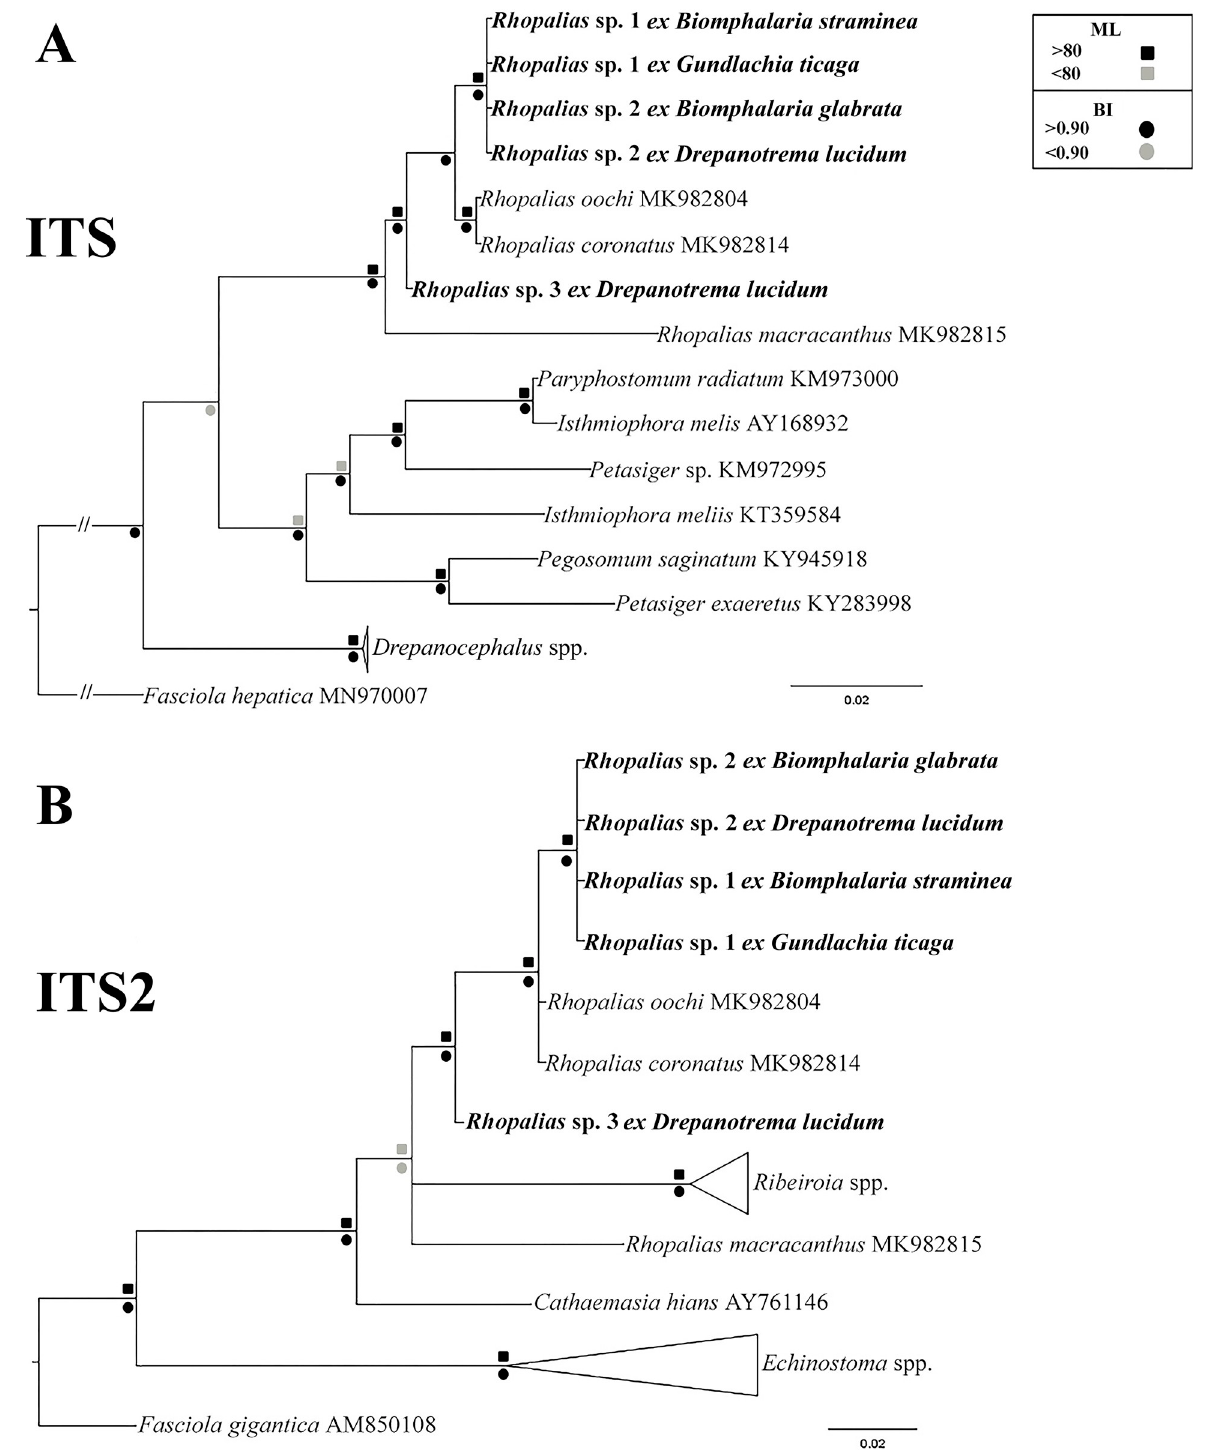
Fig 2. Phylogenetic relationships between Rhopalias spp. found in planorbids from Brazil and members of the family Echinostomatidae inferred from (A) ITS1-5.8S-ITS-2 (954 bp) and (B) ITS2 (378 bp) sequence data. The trees were generated by Bayesian Inference (BI) and Maximum Likelihood (ML) methods. New sequences from the present study are in bold. Scale bar represents the number of nucleotide substitutions per site.